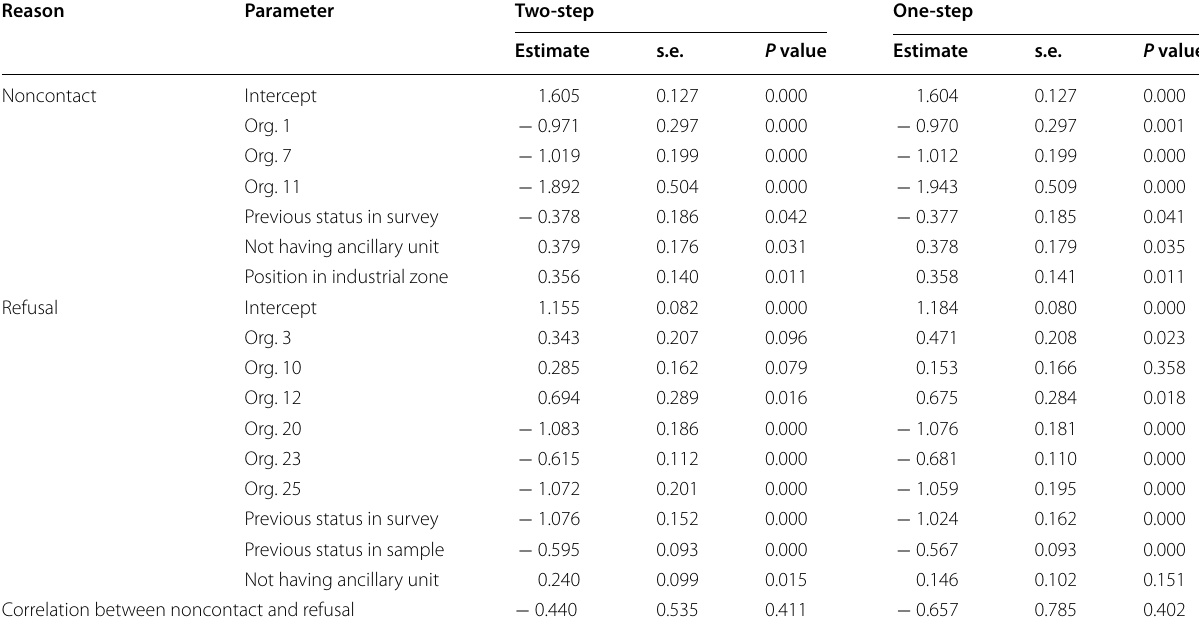
Table 6 Estimates of parameters, standard errors (s.e.) and P values in the bivariate selection model using two-step and one-step methods